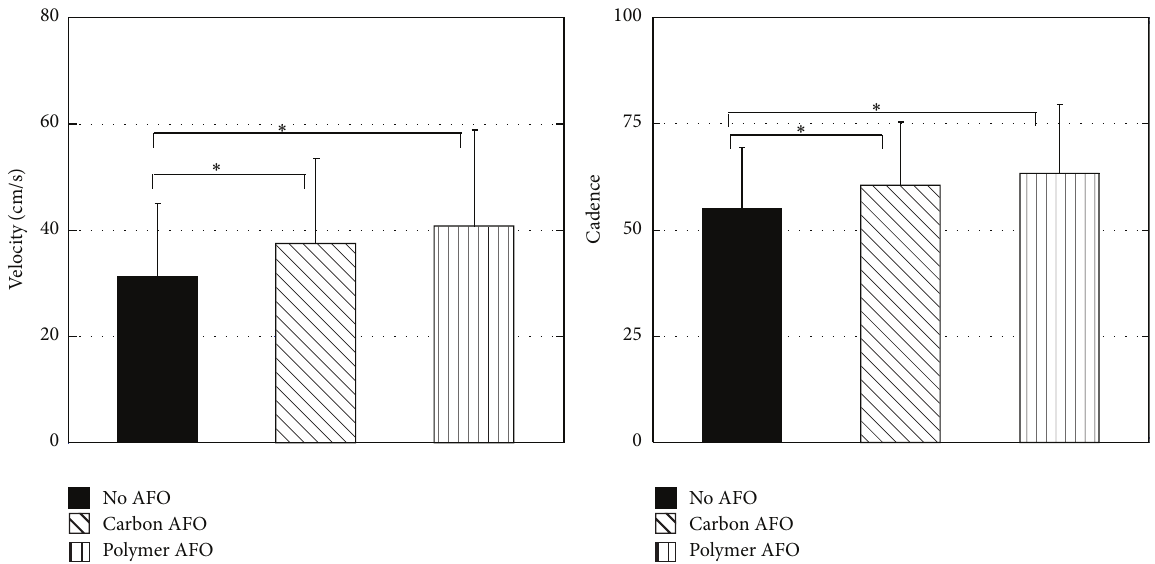
Figure 2: Gait velocity and cadence measured while walking without an AFO and with a carbon AFO or plastic AFO. ∗ shows statistical significance ( 𝑃 < 0.001 ).